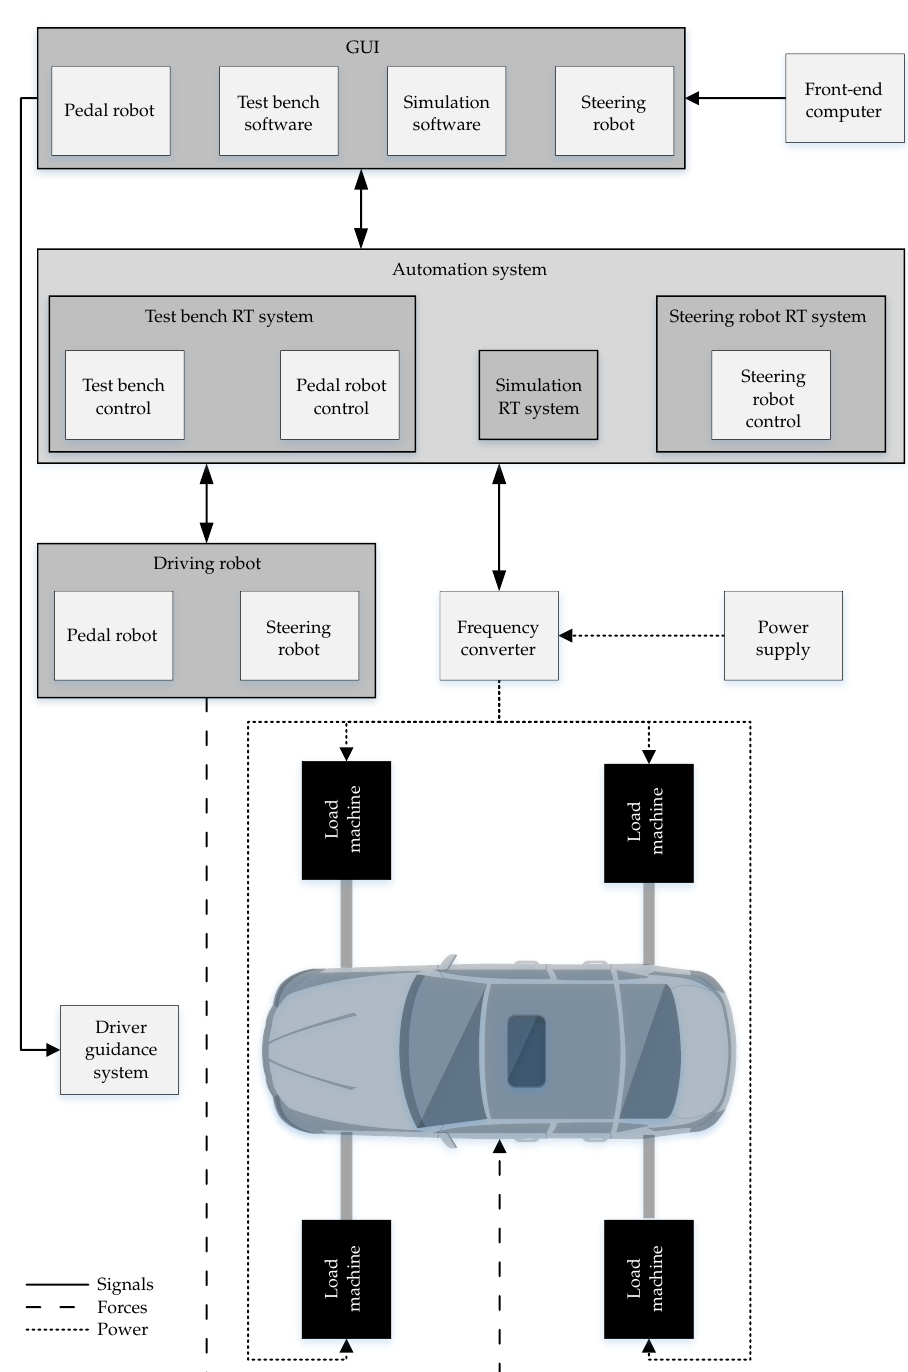
Figure 4. Schematic representation of the interconnection logic at the test